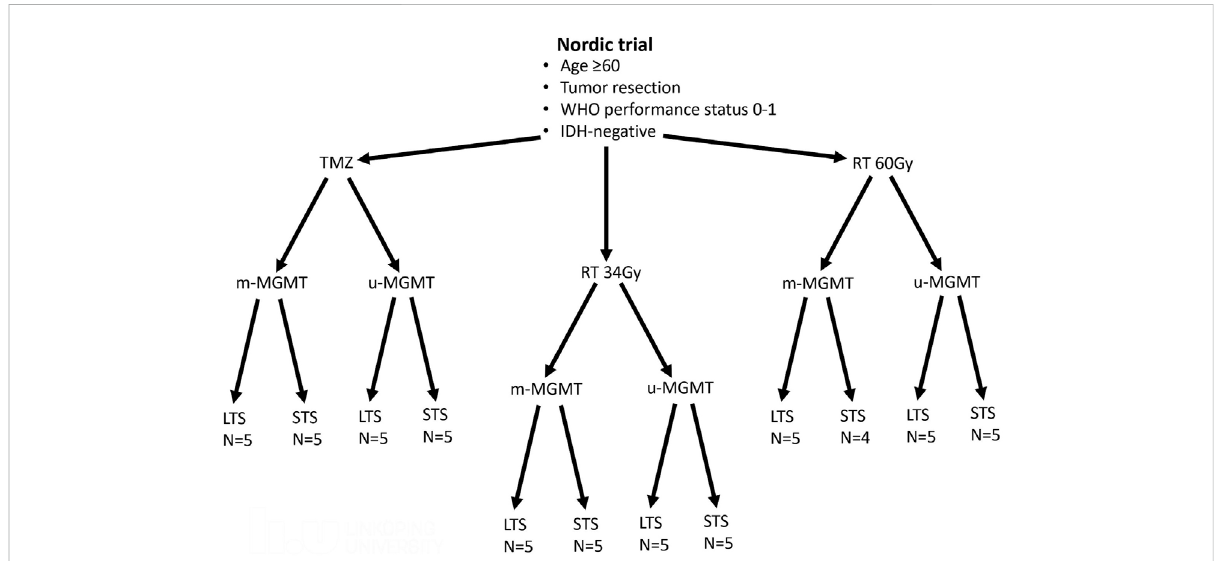
FIGURE 1 Patients from the Nordic trial included in the study. Patients with good prognostic factors were selected from each treatment arm (temozolomide -TMZ, radiotherapy 34Gy-RT 34Gy, and radiotherapy 60Gy- RT60Gy). Half of the tumors had methylated MGMT promoter (m-MGMT), and half had unmethylated MGMT promoter (u-MGMT). These patients were further divided into long-term survivors (LTS) and short- term survivors (STS). N, number of patients.